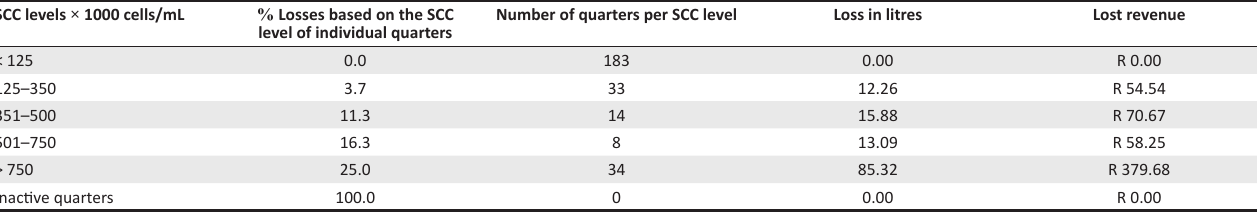
TABLE 5: Estimated milk production losses in a herd associated with elevated quarter milk somatic cell counts of all lactating cows in the herd. SCC levels × 1000 cells/mL % Losses based on the SCC level of individual